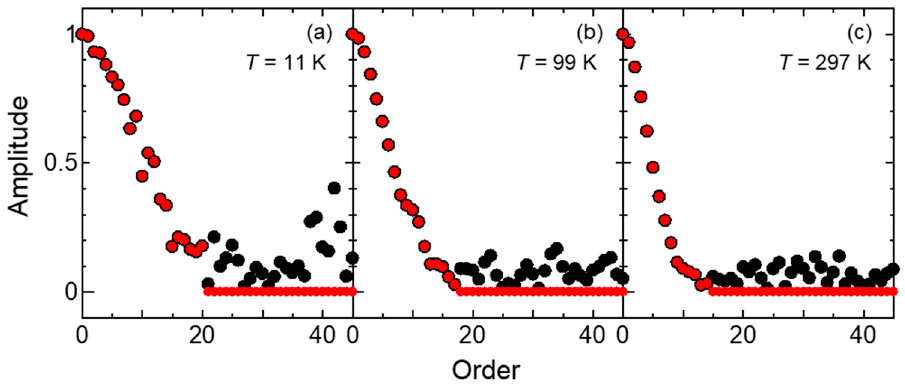
Figure 4. Fourier-transformed amplitude spectra before zero substitution (black) and after zero substitution (red) for the spectra measured at 11 K ( a ), 99 K ( b ), and 297 K ( c ).